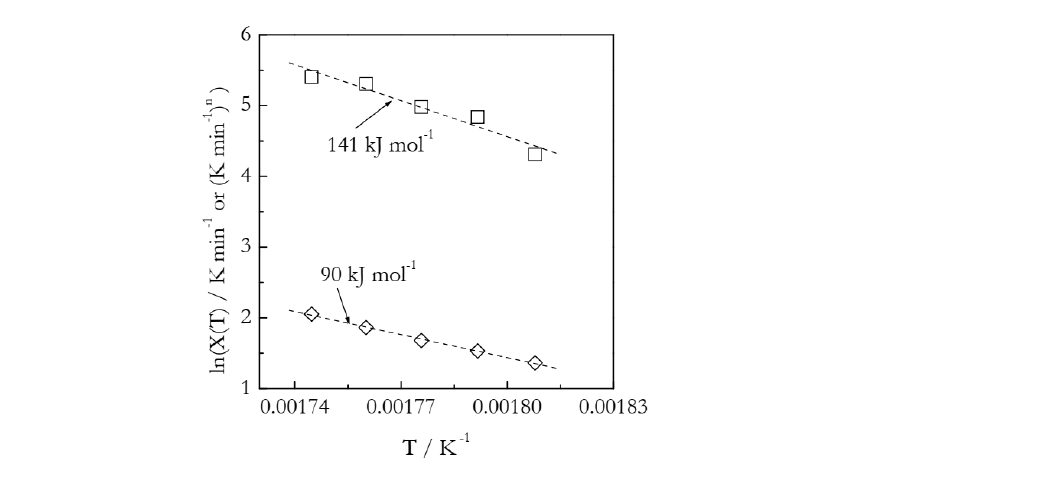
ln χ ( T ) and ln χ ( T )/ n values. Dash lines are least square fits to the respective points.